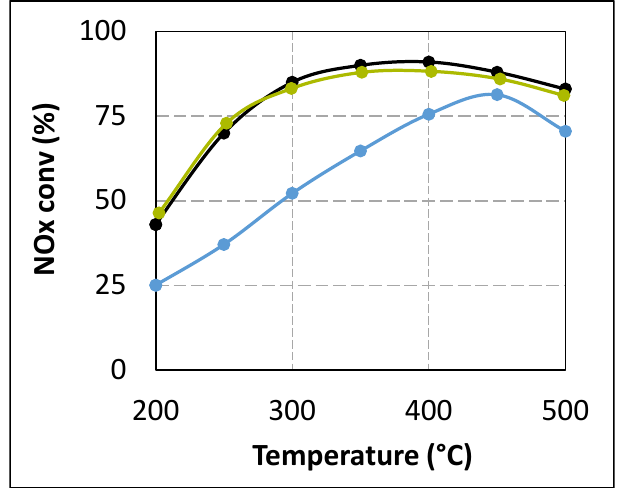
Figure 5. Effect of ammonia offset in urea-SCR gas mixture at urea residence time t R = 4.0 s on NO x conversion in standard SCR condition. ( ▬ ): Urea-SCR t R = 4.0 s; ( ▬ ): Urea-SCR t R = 5.2 s; ( ▬ ): Urea-SCR t R = 4.0 s + NH 3 . Table 2. NO 2 /NO x outlet ratio (%) versus temperature for standard-SCR (400 ppm